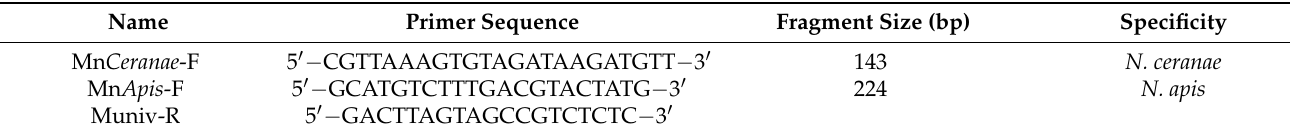
Table 1. Primers used to detect Nosema ceranae and Nosema apis